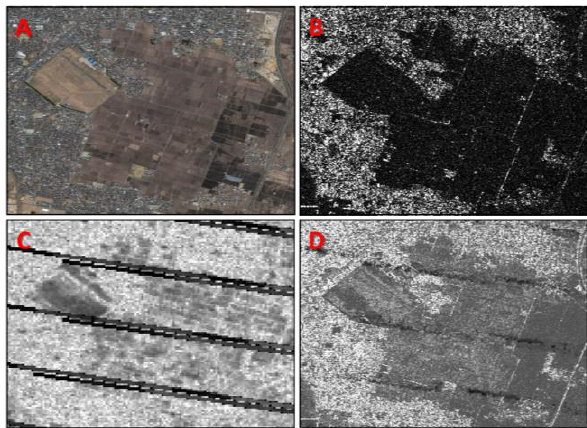
Figure 5. Comparison of crop areas: A) optical image; B) coherence map; C) CE map; D) damage assessment map. The urban area around the crops indicate high